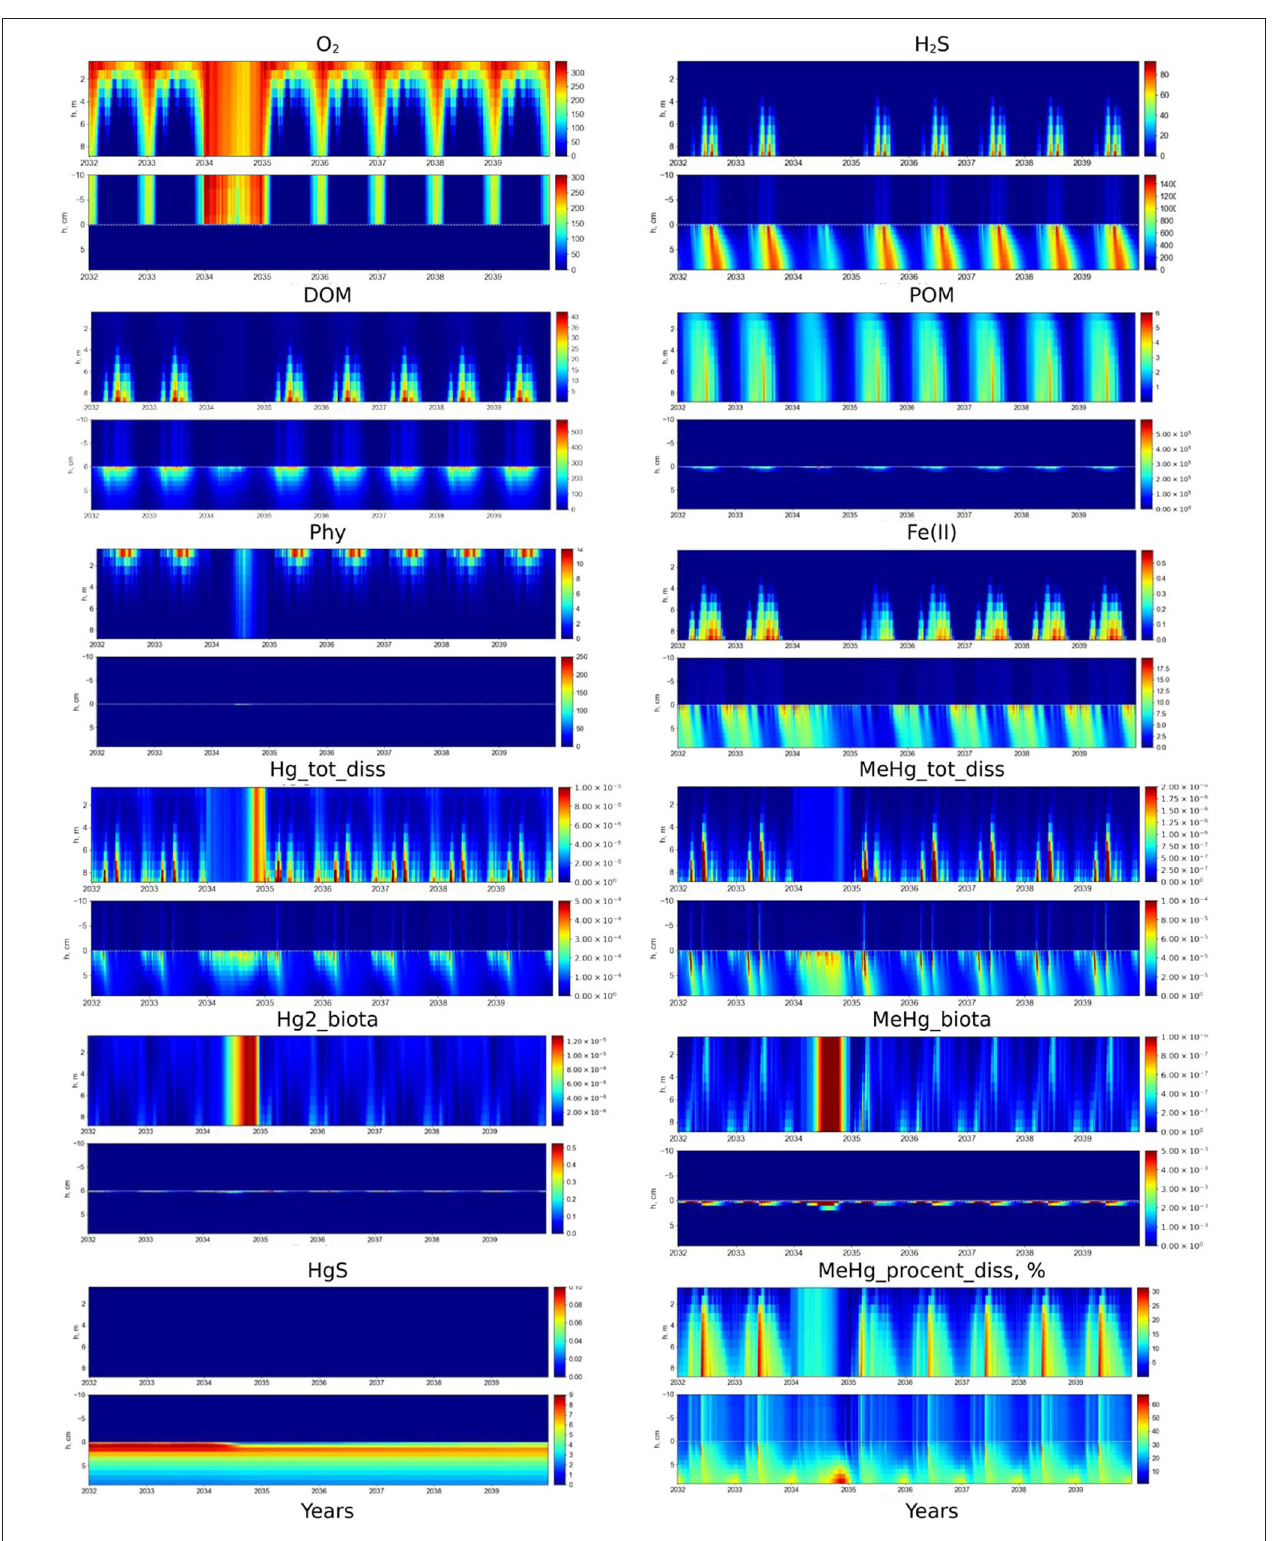
FIGURE 8 | Scenario 5. Seasonal dynamics of dissolved O 2 , H 2 S, DOM, POM, phytoplankton (Phy), dissolved Fe(II), Hg(II), MeHg, bioaccumulated Hg(II) and MeHg, HgS ( µ M), and %MeHg in the water column and at the sediment-water interface ( ± 10cm) in the Berre lagoon. The first 2 years on the figure represent the present state of the lagoon, then 1 year of increased mixing (01.2034 - 12.2034) and then 5 years after the mixing was stopped.